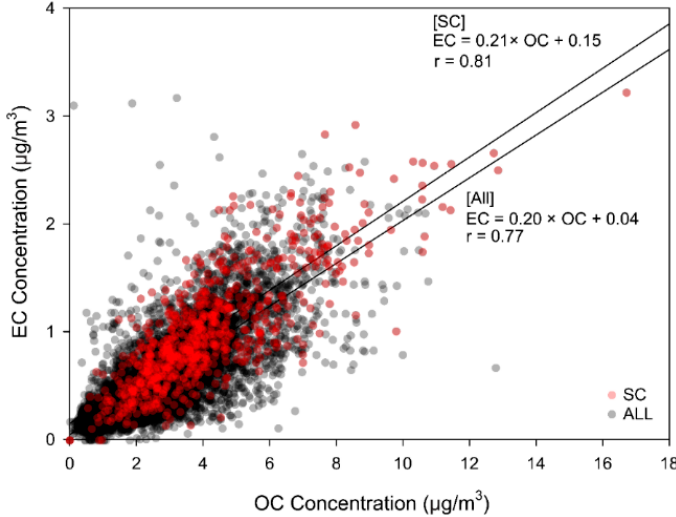
Figure 10. Correlation between organic carbon (OC) and elemental carbon (EC) concentrations in ALL and SCs (all cases: black, SCs: red).